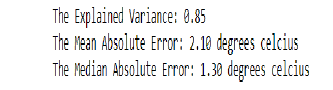
Figure 4 . Errors for Estimates